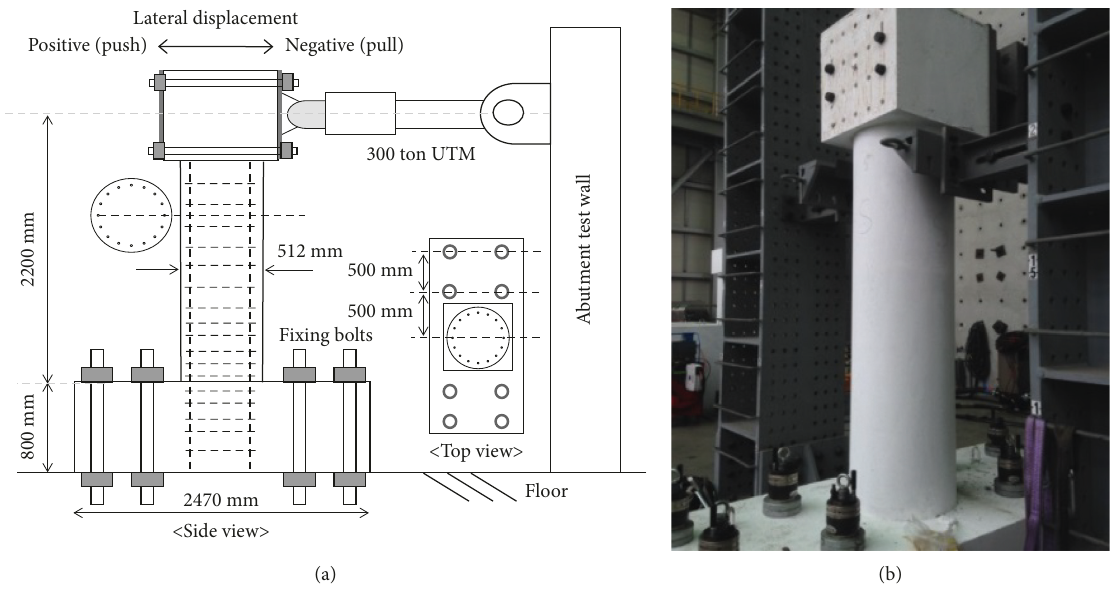
Figure 7: Test setup: (a) layout of loading and (b) the specimen on the frame.